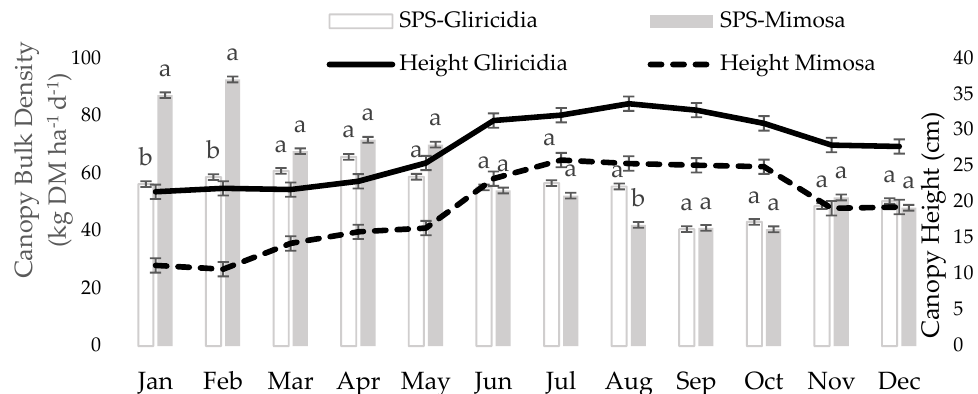
Figure 6. Canopy bulk density and canopy height of signalgrass growing in Gliricidia and Mimosa silvopasture systems